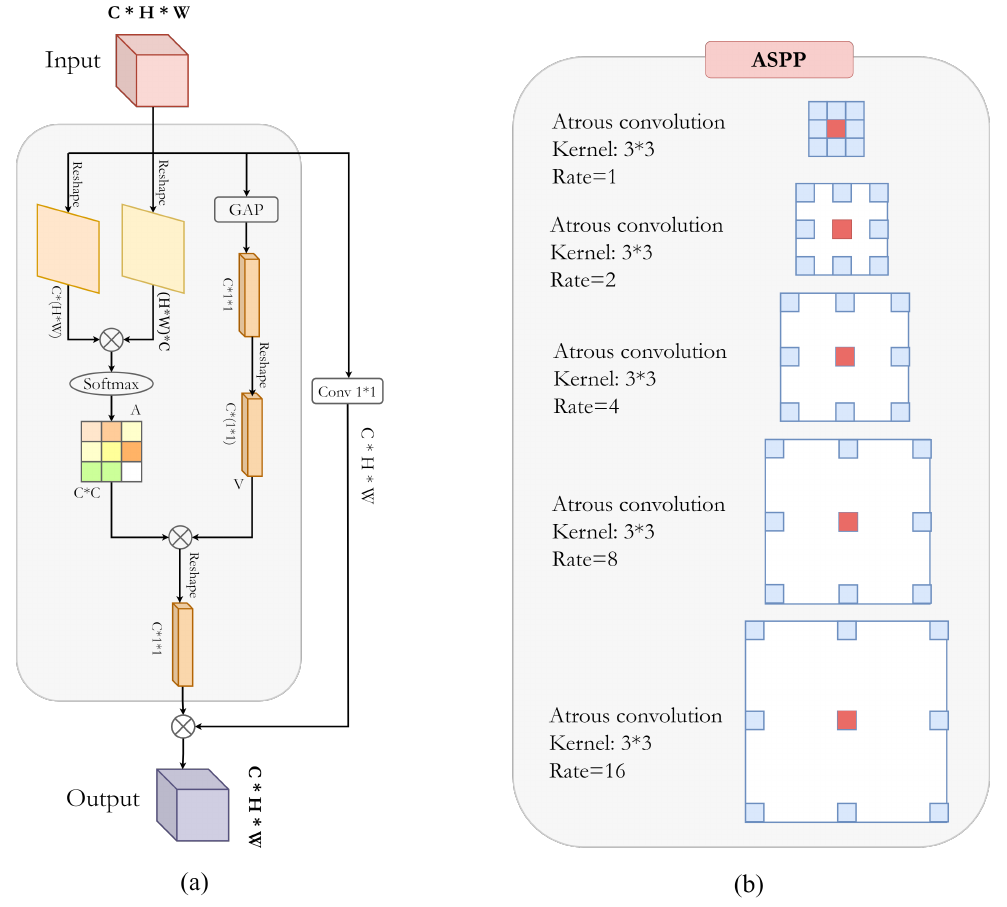
Figure 3. The structure of the attention block and ASPP. ( a ) The structure of the channel attention block. ( b ) APPP exploits multi-scale features using multiple parallel filters with different rates with the aim of classifying the center pixel